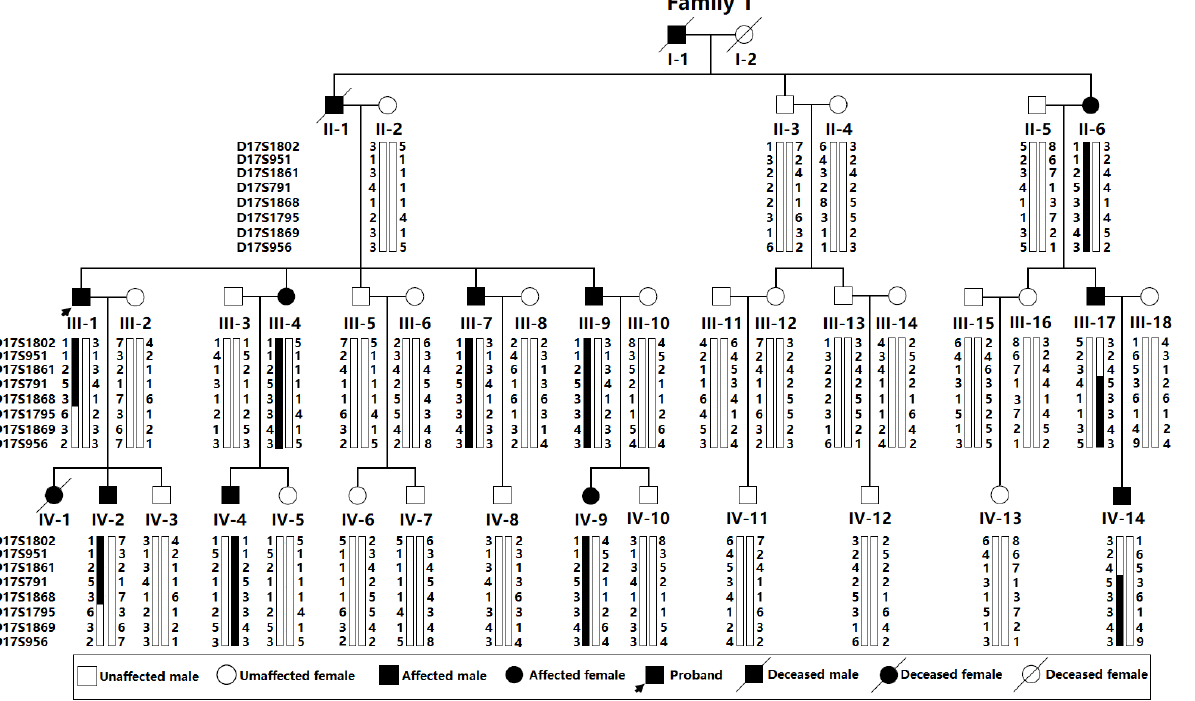
Figure 1. Pedigree and haplotype assay of a large family affected with autosomal dominant congenital heart disease and cardiac arrhythmias. Vertical bars represent the chromosomal segments determined by genotypic analysis with microsatellite markers. Selected microsatellite markers at or near the genetic linkage region on chromosome 17q21.31-q21.33 are exhibited on the left sides of the pedigree, with each family member’s marker-related genotypes given beside the chromosomal bar. A dark vertical bar indicates an affected haplotype, and a white vertical bar indicates a normal hap- lotype.